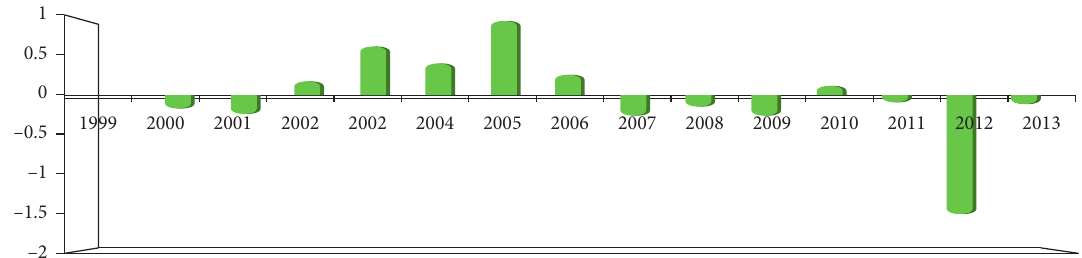
Figure 5: Mean annual deviation in minimum temperature ( ° C) in the Bawku Municipality.